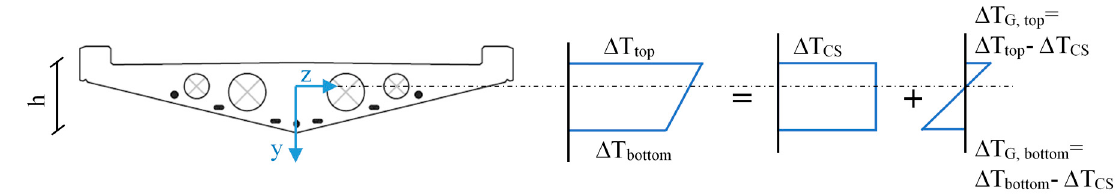
Figure 2. Example of a bridge cross-section with linear temperature distribution.